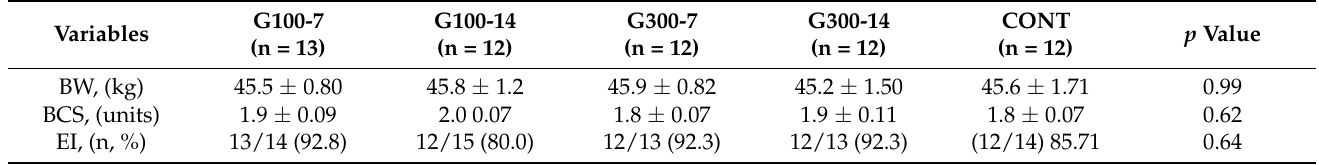
Table 1. Least-square means ± standard error for body weight (BW), body condition score (BCS), and estrus induction (EI) according to the experimental treatment to be exposed after to the fixed time artificial insemination protocol, in multiracial, multiparous, and anovulatory goats (n = 61, Alpine, Saanen, Nubian x Criollo) managed under extensive conditions in Northern Mexico (April, 25 ◦ N) 1 .